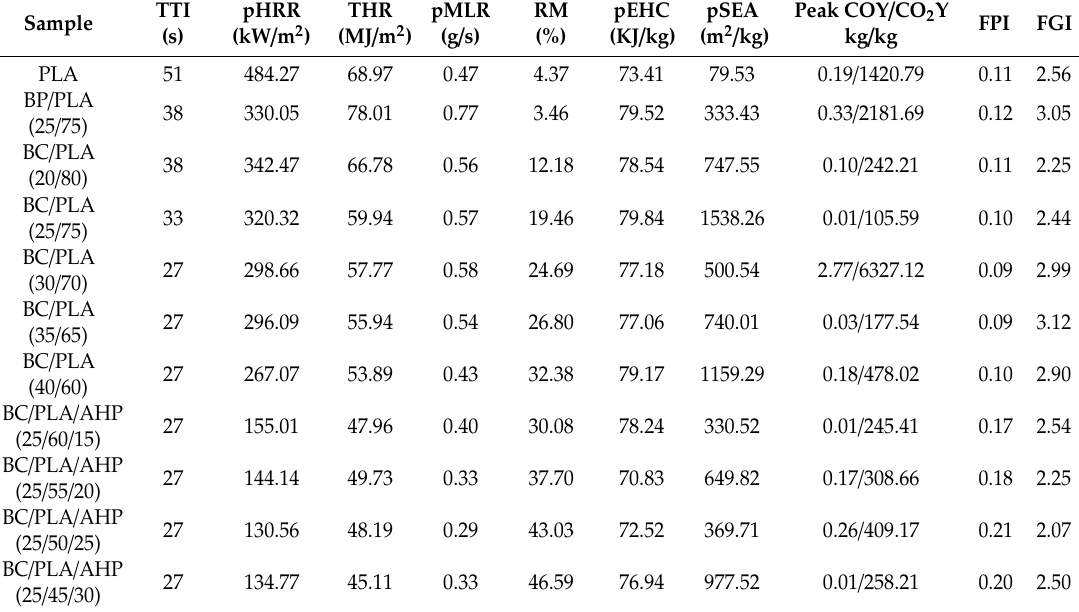
Figure 7. Appearance of test materials before and after cone calorimeter test. Table 6. Cone calorimeter data for PLA, BP / PLA, BC / PLA and BC / PLA / AHP